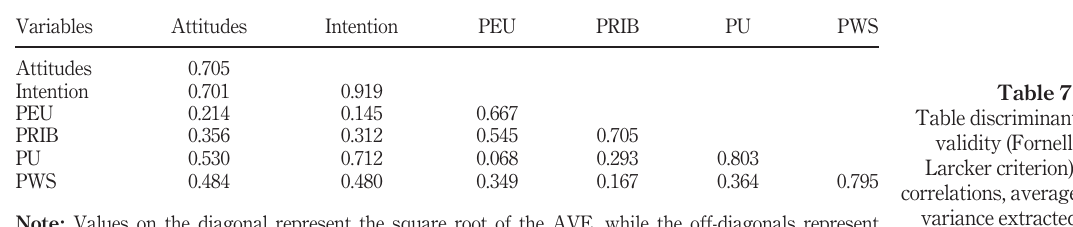
Table 7. Table discriminant